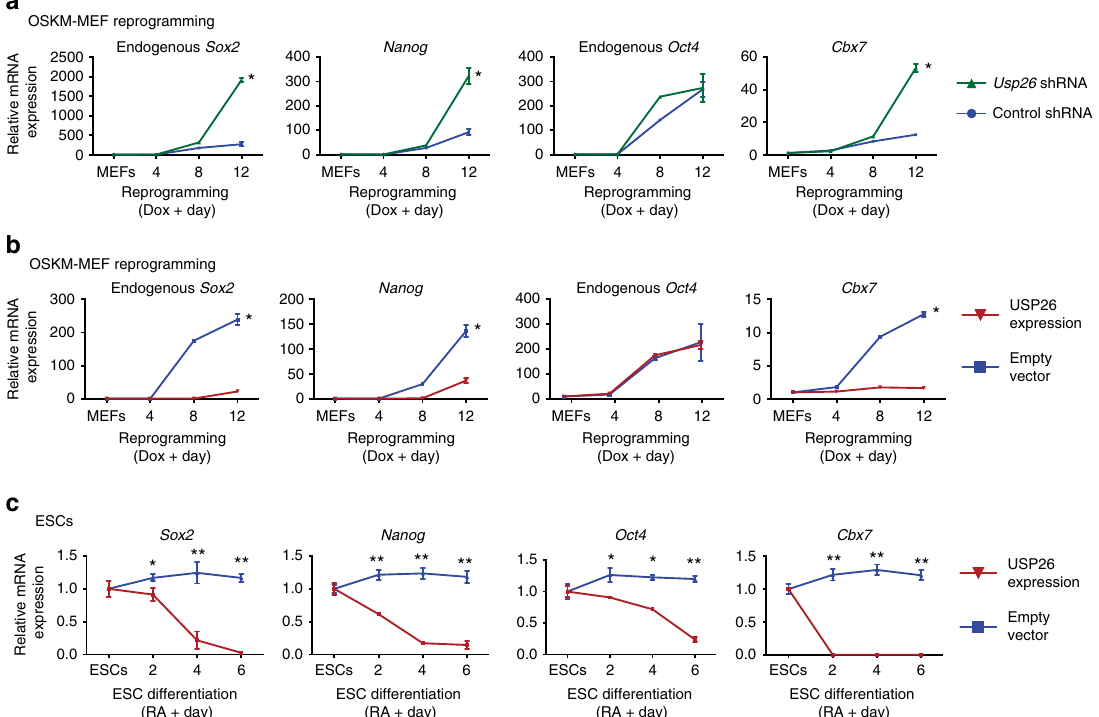
Fig. 3 USP26 inhibits pluripotency and polycomb gene expression. a Real-time PCR (qPCR) analysis of mouse Sox2 , Nanog , Oct4 , and Cbx7 mRNA expression in Usp26 or control shRNA lentivirus-transduced OSKM MEFs (* p < 0.05 compared to control shRNA). b , c Real-time PCR (qPCR) analysis of mouse Sox2 , Nanog , Oct4 , and Cbx7 mRNA expression in OSKM MEFs b and ESCs c transfected with mouse Usp26 or empty vector (EV; * p < 0.05 compared to EV, ** p < 0.01 compared to EV). The data are presented as means ± SD from three independent experiments. a – c Two-way ANOVA